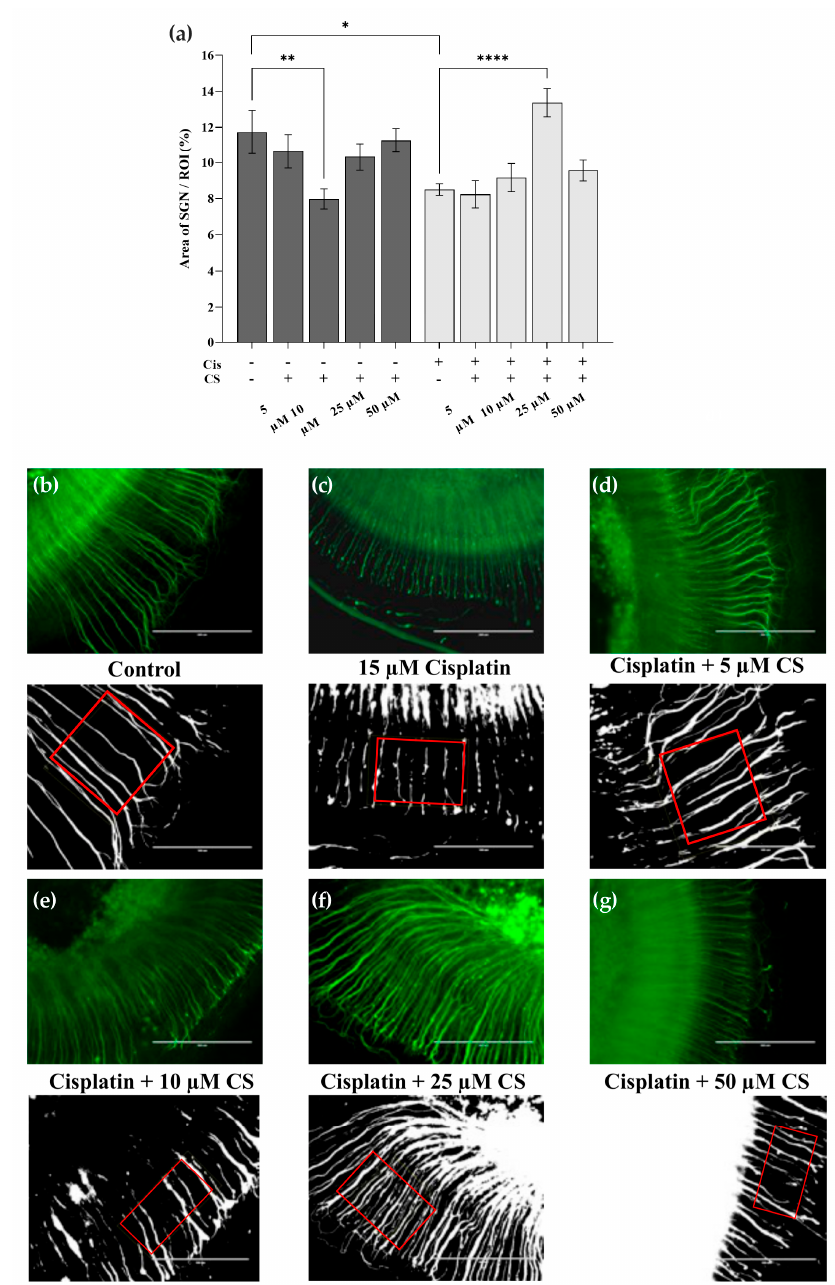
Figure 9. Pretreatment of cochlear explants with 25 µM cromolyn protects SGN from cispla tin- induced neurotoxicity. The control groups (n = 4 in each case) were either untreated or incubated with CS (5, 10, 25, 50 µM) for 24 h. The treatment groups (n = 4 in each case) were pretreated with 5, 10, 25, and 50 µM CS for 2 h and then exposed to 15 µM cisplatin for 24 h. The control and treatment groups were compared to the cisplatin group. The explants were labeled with NF200 and a secondary antibody conjugated with the Alexa FluorTM 488. The areas containing the SGN were quantified in five representative sections of the apical, medial, and basal fragments. The ROI area was measured between the habenula perforata and the IHC and given as a percentage. ( a ) Between-group differences in ROI. ( b – g ) Representative micrographs demonstrate SGNs in the respective treatment groups and the associated binary images. The ROI areas are outlined in red. The scale bar in the SGN images represents 200 µ m and 100 µ m in the binary images. The data represent four independent experiments and are reported as mean ± SEM. * p < 0.05; ** p < 0.01; **** p < 0.0001 (two-way ANOVA with Dunnett multiple comparison